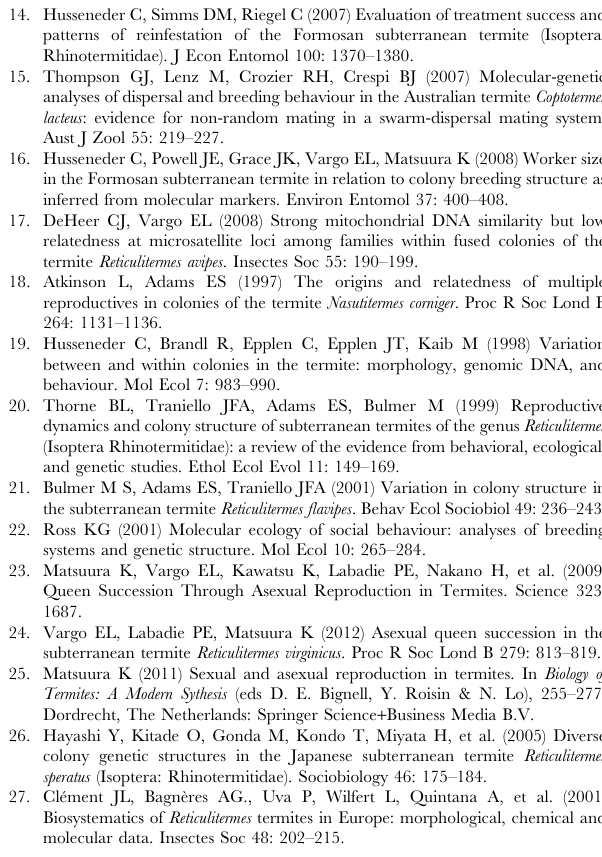
Figure S1 Evanno plot derived from STRUCTURE HAR- VESTER for detecting number of genetic clusters. Figure S2 Assignment of colonies to genetic clusters by STRUCTURE (K = 2). Figure S3 Primary and secondary reproductives of Reticulitermes chinensis collected from field colonies in Wuhan City. (a), primary king (PK) and primary queen (PQ). (b), secondary kings (SK) and secondary queens (SQ). Table S1 Genetic distance ( F ST ) among the four populations. Table S2 Composition of secondary reproductives in the five field colonies.